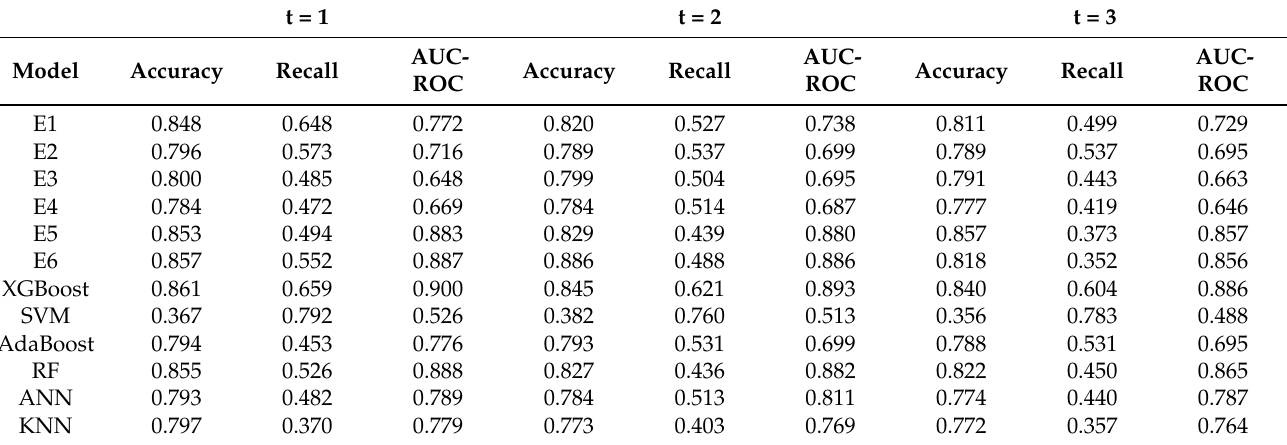
Table 9. Detailed results of model evaluation using 6 h of look back data and 1, 2, and 3 h prediction